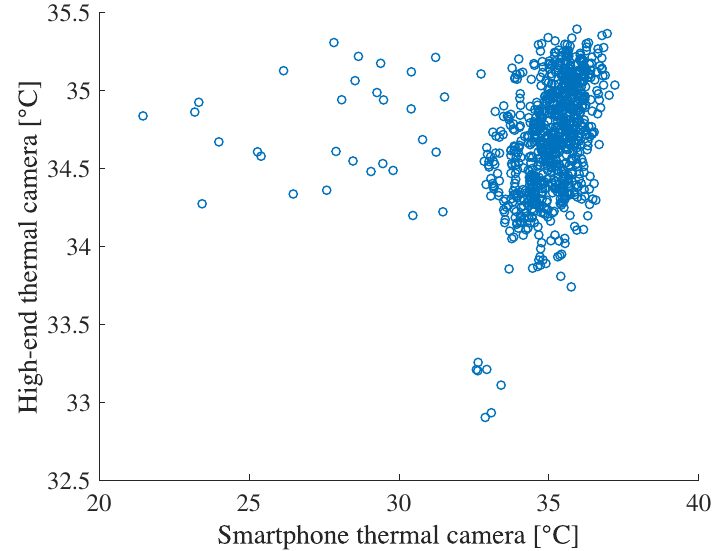
Figure 9. Relation between face temperatures measured by a high-end thermal camera and smartphone thermal